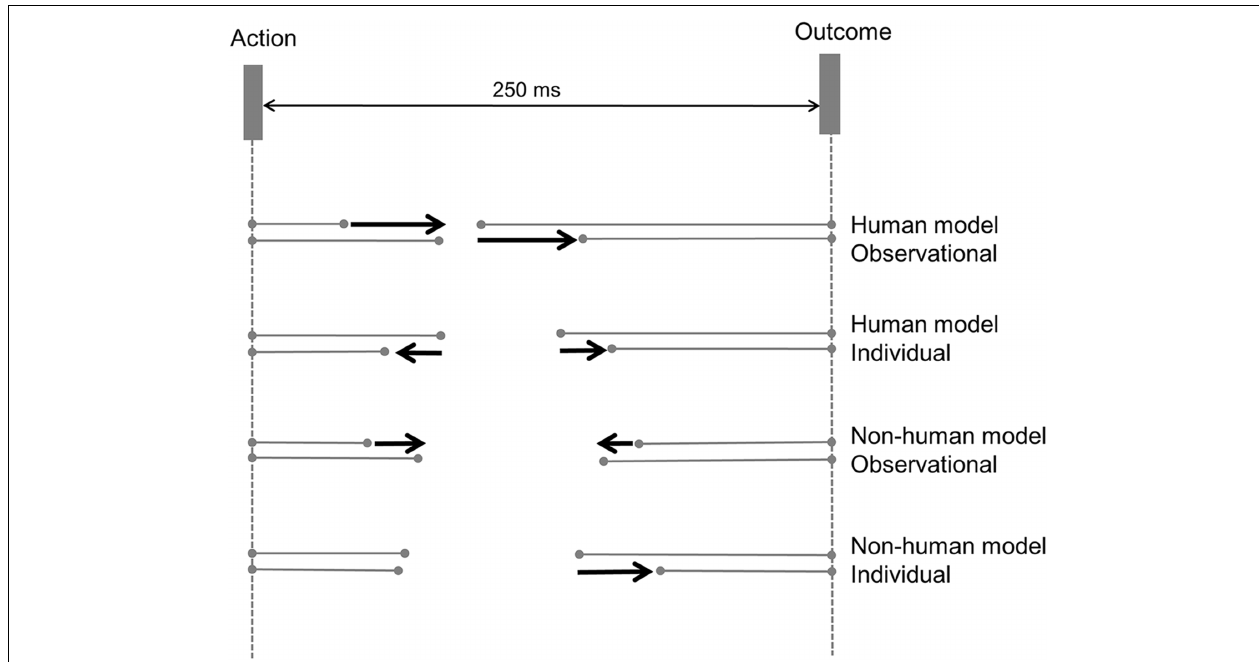
FIGURE 4 | The evolution of action and tone binding, plotted separately for each experimental group. In each group, average binding in the first and last 10 trials is shown in the upper and lower lines, respectively (lines with endpoints). Thick black arrows illustrate the change in action and tone binding over successive trials. A rightward arrow corresponds to an increase in action binding, but a decrease in tone binding. A leftward arrow corresponds to a decrease in action binding, but an increase in tone binding. Binding effects are drawn to